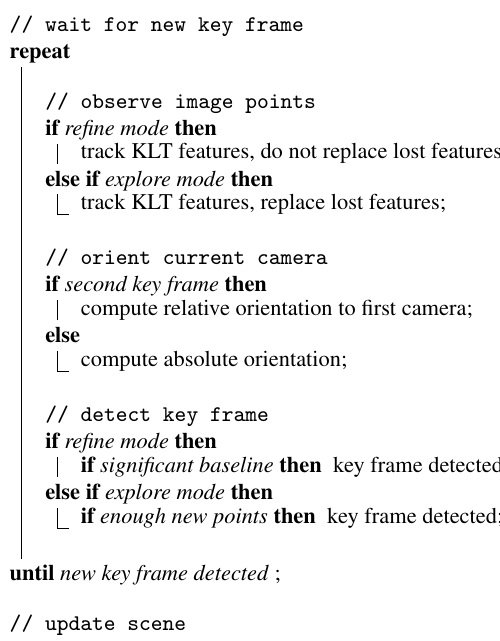
Algorithm 1 : Overview of the proposed camera framework. See Section 3.5 for a detailed